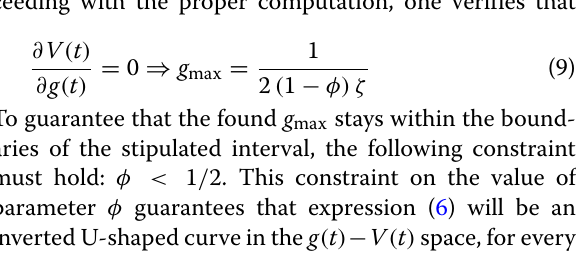
Given Eqs. (1) and (5), one can suppress the social dam- age variable from the analysis, and establish a straightfor- ward relation between TFP and the social responsibility variable,